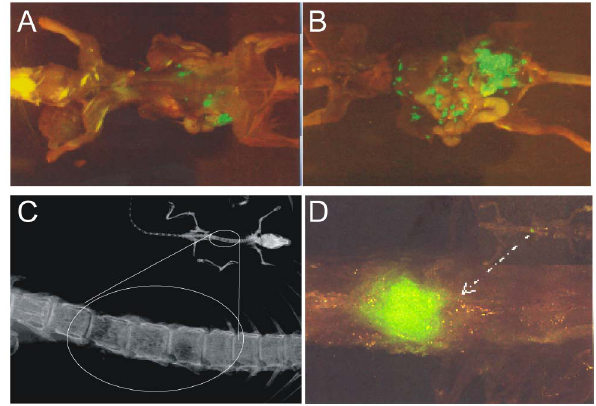
Figure 4. PTHrP Promotes Tumorigenesis in Orthotopic Mouse Model. A) Orthotopic mouse model showing a mouse injected with DU145-GFP cells. B) Mouse injected with DU 145-PTHrP(1–173) cells. C) Evidence of bone destruction in mouse injected with DU 145-PTHrP(1– 173) cells. D) Spine metastasis in a mouse injected with DU 145- PTHrP(1–173)